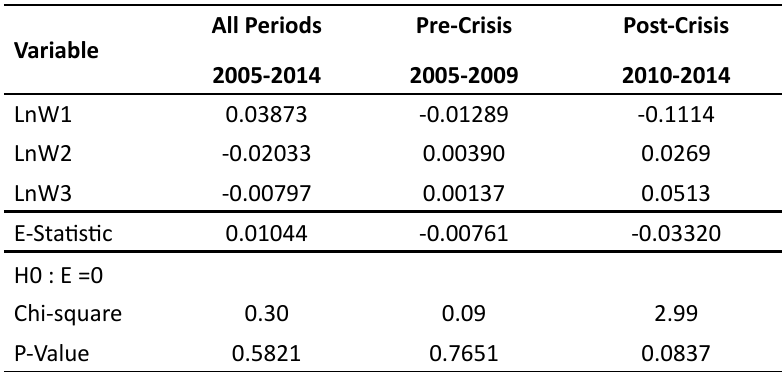
Table 4: Summary of E-Statistic